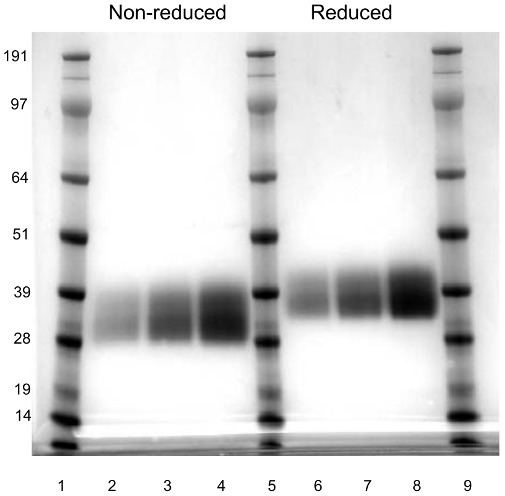
Purified DM199.1, 2 and 4 µg of purified DM199 were either non-reduced (lanes 2, 3 & 4) or reduced (lanes 6, 7 & 8) with NuPAGE Sample Reducing Agent (Life Technologies, Carlsbad, CA) and loaded on to a NuPage Novex 4–12% BIS-TRIS pre-cast polyacrylamide gel (Life Technologies). The gel was stained with Colloidal Blue Staining (Life Technologies, Carlsbad, CA). Lanes 1, 5 and 9: molecular weight marker (SeeBlue Plus2 Standard, Life Technologies, Carlsbad CA).